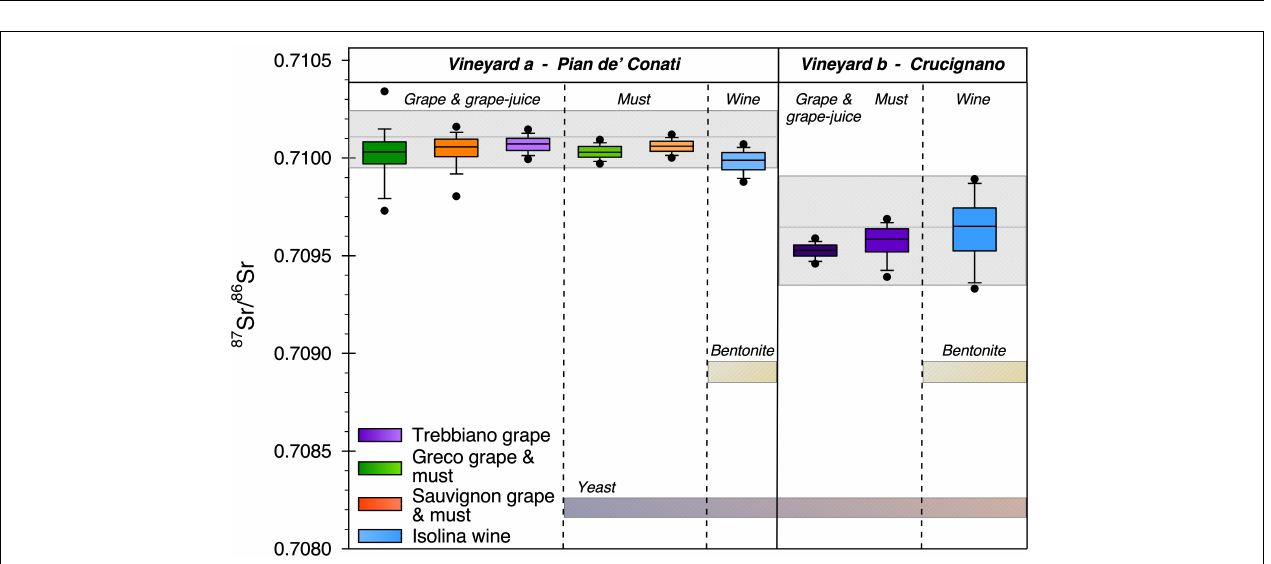
FIGURE 6 | 87 Sr/ 86 Sr values in grape, juice, musts, and wine for the Numero Sei wine (from the 2006, 2007, and 2011 vintage years). Numero Sei wine is composed by a blending of Greco and Sauvignon varieties, which are both grown in the area of Pian de’ Conati (vineyard a ). The box plot features are reported through text and in the caption of Figure 2 . The gray pattern represents the whole range of variability of the soil bioavailable fraction; the solid line represents the mean value. The shaded bars represent the isotopic range of the analyzed additives, bentonite, and yeast, respectively. The length of the bars depends on the wine-making step in which such additives are introduced, thus the different matrix in which we investigated their potential effect.